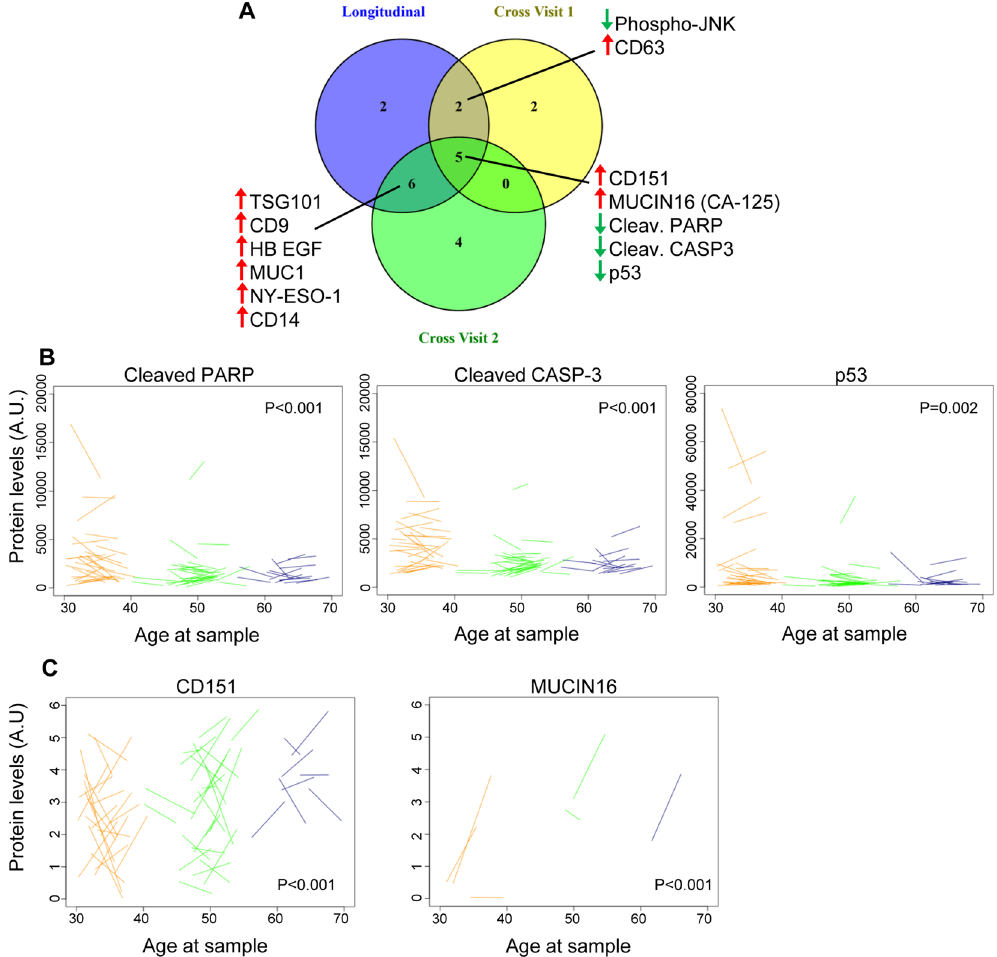
Figure 5. Significant changes in EV protein levels with age. ( A ) EV protein levels in 74 individuals at two different visits were quantified by EV Array or ELISA (see Methods for distinction). Linear mixed-effects models were used to determine whether EV protein levels changed significantly longitudinally (between visit 1 and visit 2) or in cross-sectional analysis of visit 1 or visit 2. Proteins that changed significantly in more than one analyses are listed and the direction of change is indicated by the up and down arrows. ( B ) Representative spaghetti plots for EV proteins that are significantly changed with age both in our longitudinal and cross- sectional analyses. The start of the line represents protein levels at time point 1 and the end of the line represents protein levels at time point 2. A.U. = arbitrary